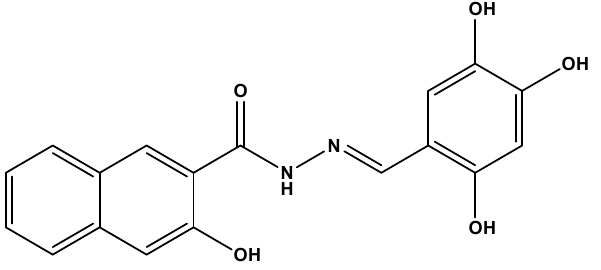
Figure 13. Structure of Dyngo-4a, potency against OGT: IC 50 = 6 μM; potency against dynamic GTPase (Dynl): IC 50 = 2.7 μM.